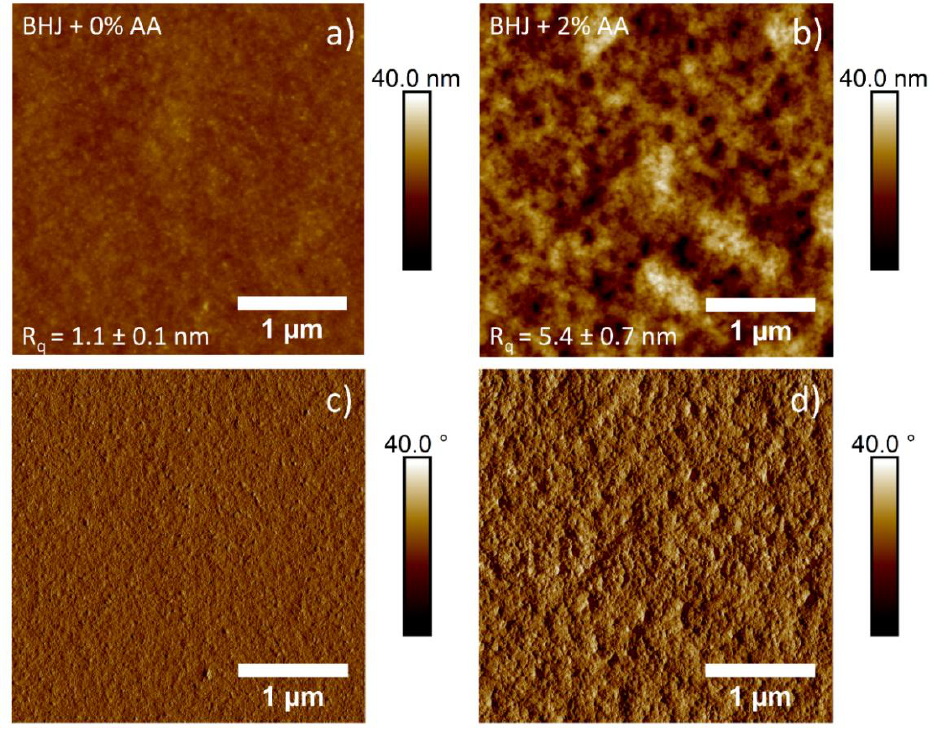
Figure 1. AFM topography height ( a , b ) and phase ( c , d ) images (5 µ m × 5 µ m) of the surface morphology of the BHJ with 0% AA ( a , c ) and 2% AA ( b , d ). Average R q roughness was calculated from 5 scan locations per sample.